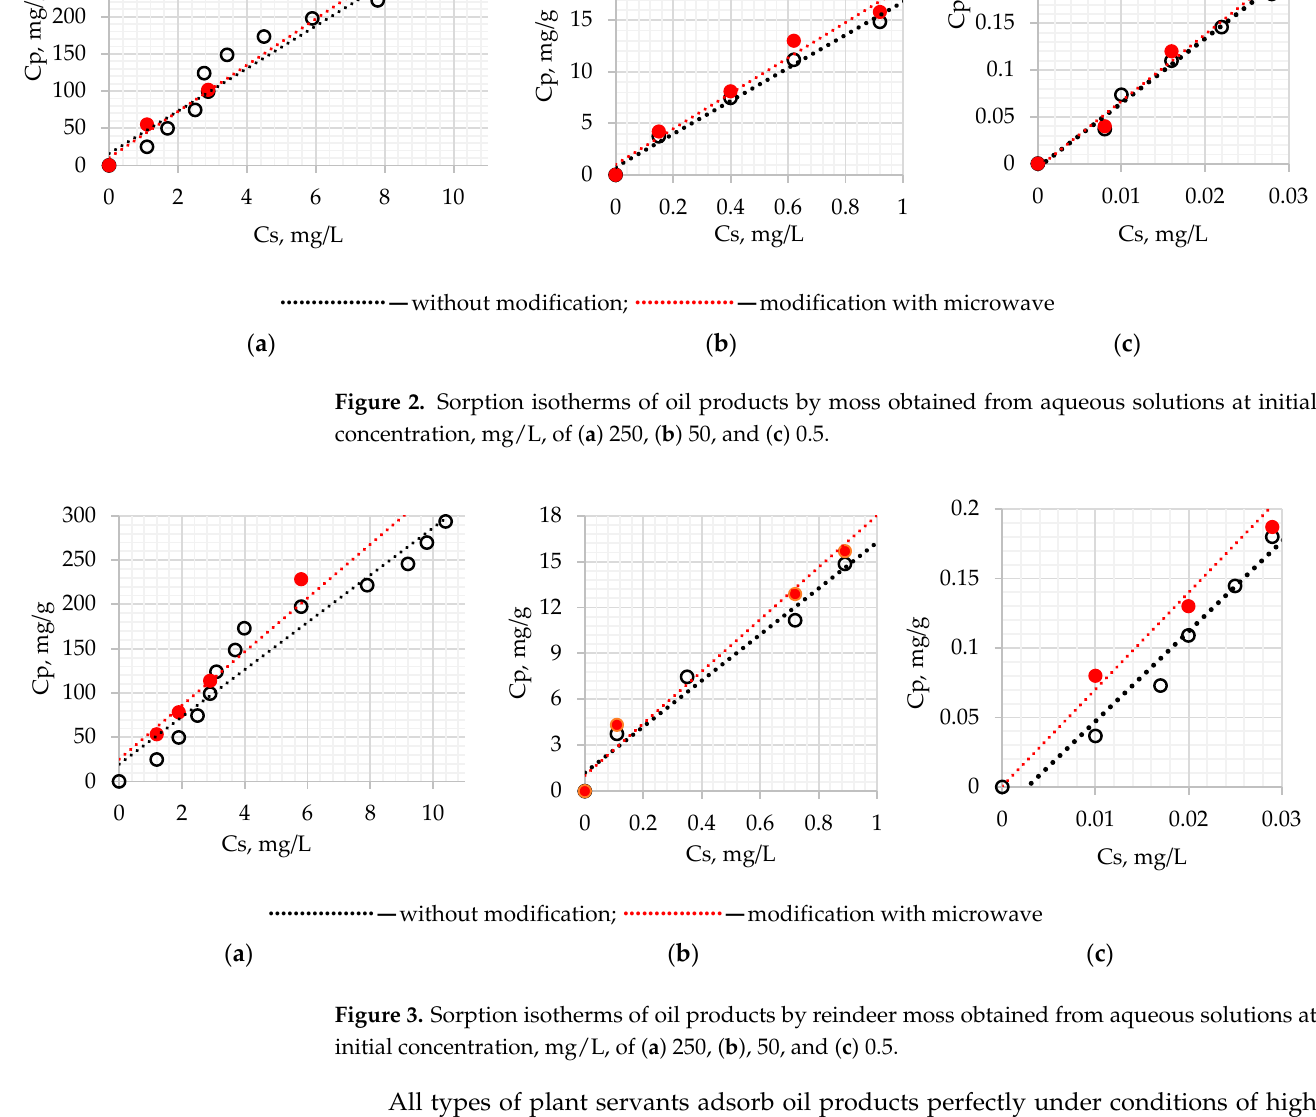
initial concentration (250 mg/L), and much worse in the case of medium (50 mg/L) and,